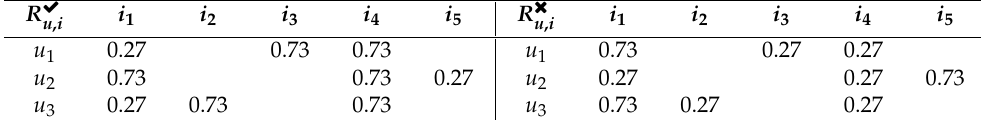
Table 2. Softmax-normalized ratings. Note that only known ratings are normalized. R ¸ u , i